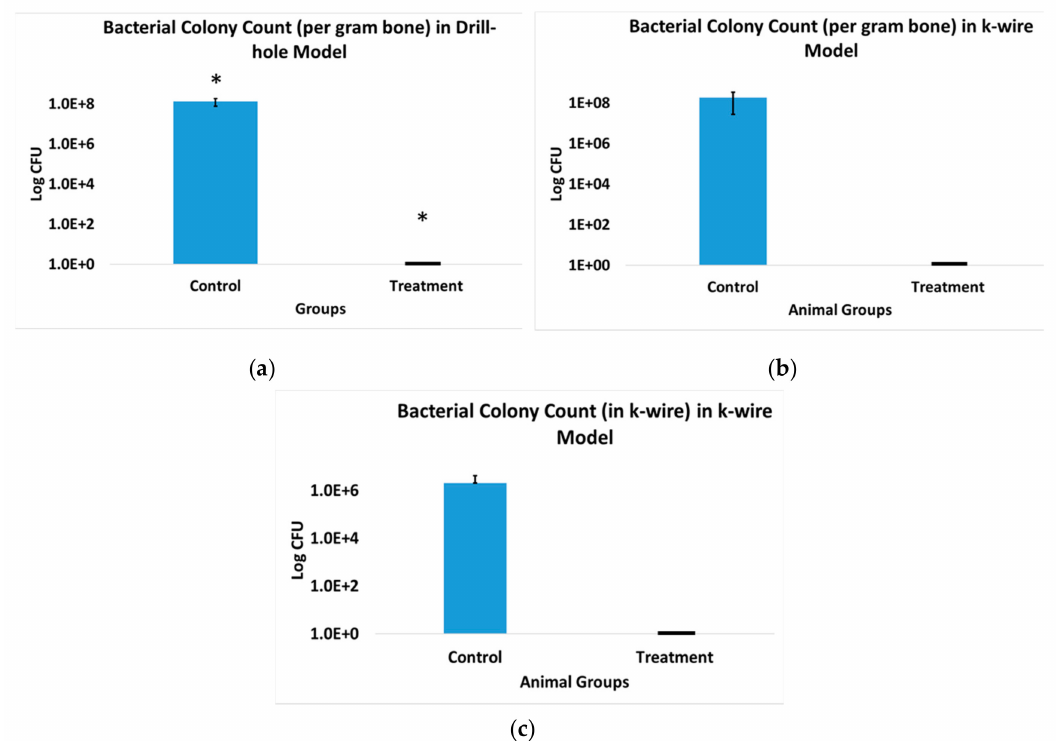
Figure 10. ( a ) The bacterial count in the drill-hole model control group showed very high bacterial count in the bone; n = 4 (control), n = 3 (treatment), * p < 0.05. The treatment group did not show any presence of bacteria and the infection was eliminated. ( b ) The bacterial count in the k-wire rat model control group showed very high bacterial count in the bone. The treatment group was free from any bacterial load and the infection was eliminated; n = 2 (control), n = 2 (treatment). ( c ) The bacterial count in k-wire rat model control group showed a high bacterial count on the extracted k-wire. The k-wire extracted from the treatment group was free from any bacterial load; n = 2 (control), n = 2 (treatment). S. aureus (ATCC 49230) was used for all the